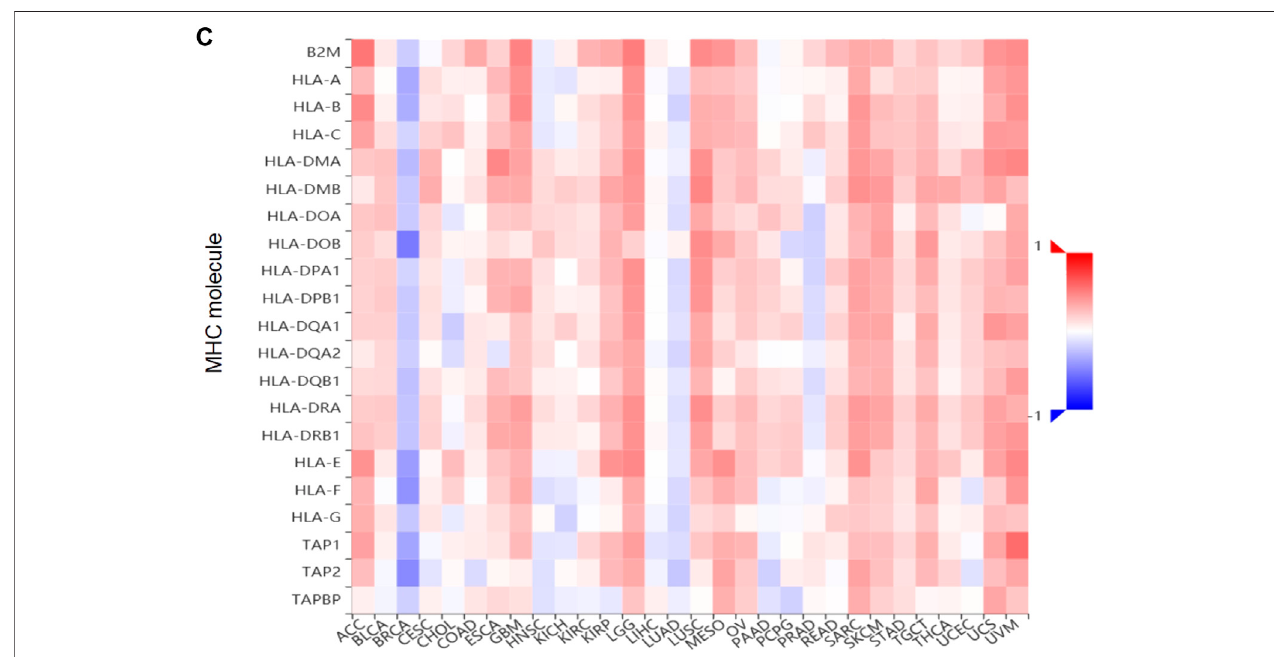
FIGURE 5 | Relations between three kinds of immunomodulators and XBP1 expression in ovarian cancer. (A) Relations between Immunoinhibitors and XBP1 expression in ovarian cancer. (B) Relations between Immunostimulator and XBP1 expression in ovarian cancer. (C) Relations between MHC molecule and XBP1 expressioninovariancancer.Redrepresentsupregulationandgreenrepresentsdownregulation.ACC,Adrenocorticalcarcinoma;BLCA,BladderUrothelialCarcinoma; BRCA, Breast invasive carcinoma; CESC, Cervical squamous cell carcinoma and endocervical adenocarcinoma; CHOL, Cholangiocarcinoma; COAD, Colon adenocarcinoma; DLBC, Lymphoid Neoplasm Diffuse Large B-cell Lymphoma; ESCA, Esophageal carcinoma; GBM, Glioblastoma multiforme; HNSC, Head and Neck squamous cell carcinoma; KICH, Kidney Chromophobe; KIRC, Kidney renal clear cell carcinoma; KIRP, Kidney renal papillary cell carcinoma; LAML, Acute Myeloid Leukemia; LGG, Brain Lower Grade Glioma; LIHC, Liver hepatocellular carcinoma; LUAD, Lung adenocarcinoma; LUSC, Lung squamous cell carcinoma; MESO, Mesothelioma; OV, Ovarian serous cystadenocarcinoma; PAAD, Pancreatic adenocarcinoma; PAAD, Pancreatic adenocarcinoma; PCPG, Pheochromocytoma and Paraganglioma; PRAD, Prostate adenocarcinoma; READ, Rectum adenocarcinoma; SARC Sarcoma; SKCM, Skin Cutaneous Melanoma; STAD, Stomach adenocarcinoma; TGCT, Testicular Germ Cell Tumors; THCA, Thyroid carcinoma; THYM, Thymoma; UCEC, Uterine Corpus Endometrial Carcinoma; UCS, Uterine Carcinosarcoma; UVM, Uveal